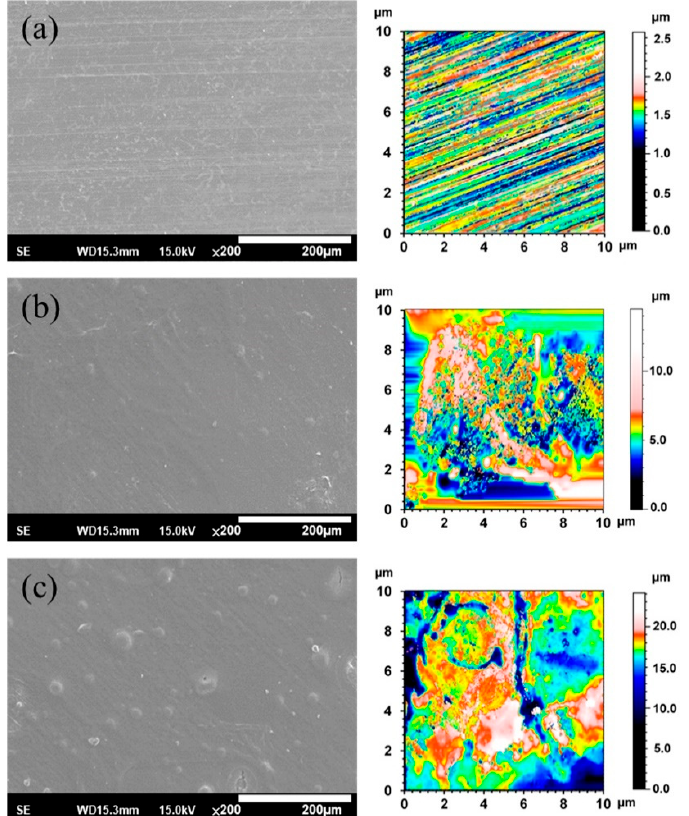
Figure 3. SEM and 2-D texture height maps of ( a ) a specimen ground with #2000 SiC paper; ( b ) ZX31(CHI/LGA) 2 specimen; ( c ) ZX31(CHI/LGA) 7 specimen.